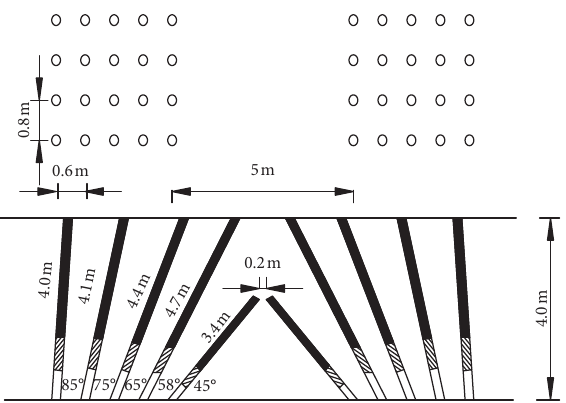
Figure 8: The arrangement of cutholes in excavation of surrounding rock masses (grade III).